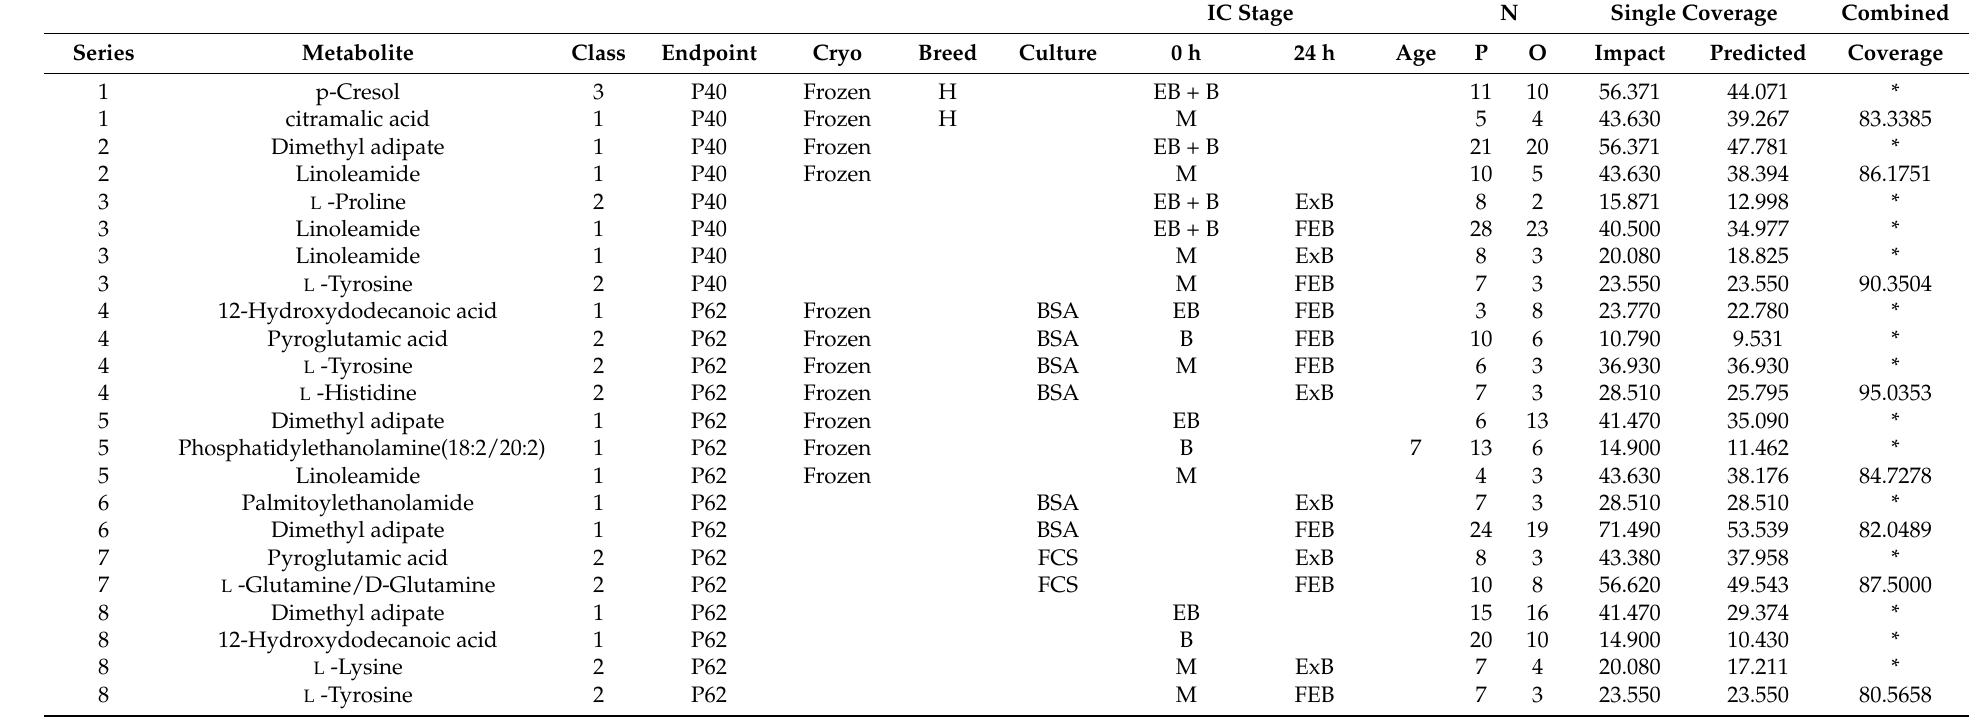
Table 5. Best metabolite block combinations (combined coverage) that predicted pregnancy (Day-40 and Day-62 and birth) (Endpoint) with >0.800 coverage within IVP embryos transferred to recipients. Each series consists of blocks with the same embryo cryopreservation, bull breed and culture conditions, and supported by embryonic stages. IVP embryos (sired by Holstein—H—or Asturiana de los Valles—AV—bulls) were cultured with albumin (BSA) or with albumin + fetal calf serum (FCS) followed by a single 24 h culture step (IC stage) developmentally defined by embryonic stage at 0 h (M: morula; EB: early blastocyst; B: Blastocyst) and at 24 h (ExB: expanding blastocyst; FEB: fully expanded blastocyst) that led to embryos aged 7 or 8 days that were transferred fresh or frozen (Cryo) to Day-7 estrus synchronized recipients. N: samples used to calculate predictions within each metabolite block (P: pregnant; O: Open). Impact: proportion of embryos represented within IC stages developed under each culture conditions. No filled data indicates the independence of this